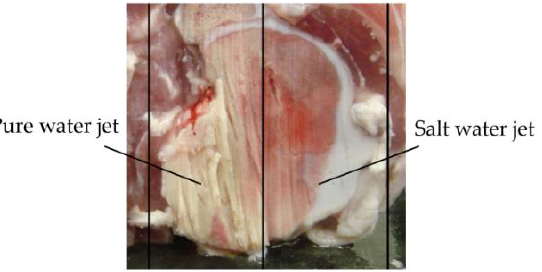
Figure 4. Contrast tests of cutting pork included bone with pure water jet and saltwater jet ([60], adapted from “Cutting meat with bone using an ultrahigh pressure abrasive waterjet” with permission from Elsevier, 2022).